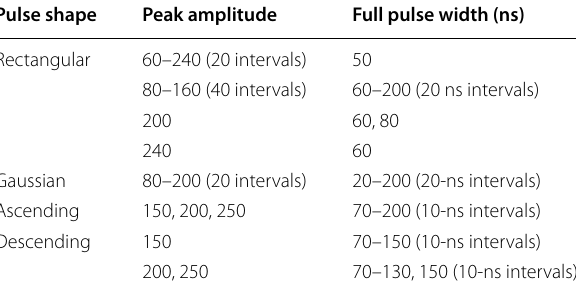
Table 2 Widths and amplitudes of pulses synthesized for